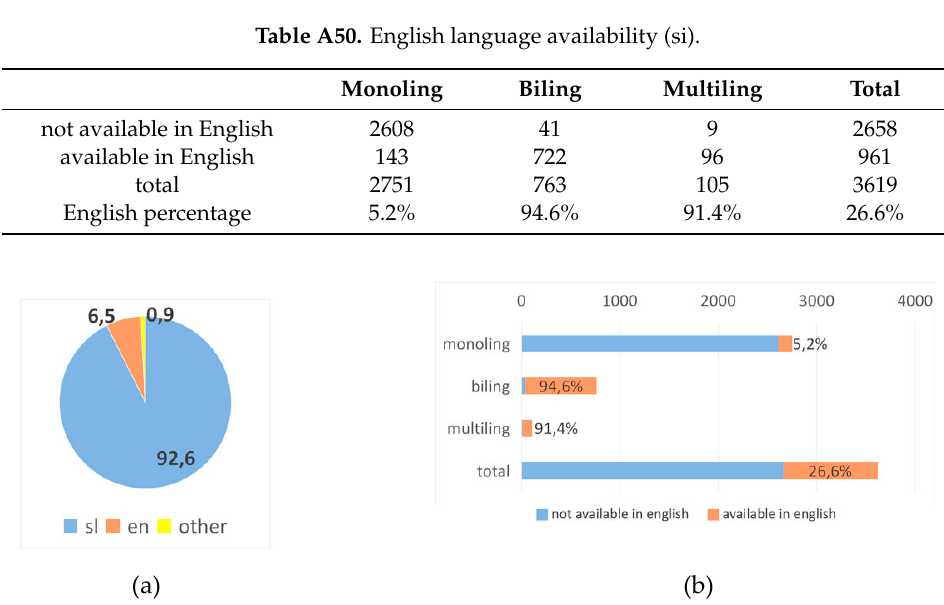
Figure A25. Visualization of the results for domain si. ( a ) Primary languages pie chart and ( b ) English